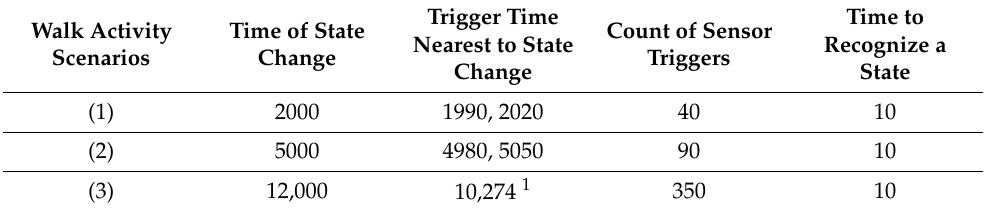
= 3431 and T 1 = 10,274 1,1 1,2